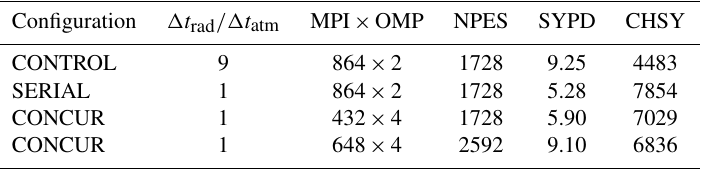
Table 1. Performance results from the various configurations discussed. MPI × OMP shows the assignment of MPI processes and OpenMP threads. In the CONCUR cases two threads each are assigned to atmosphere and radiation components. NPES is the total PE count (MPI × OMP). SYPD measures throughput in simulated years per day, and CHSY is the computation cost in processor hours per simu- lated year (NPES ×